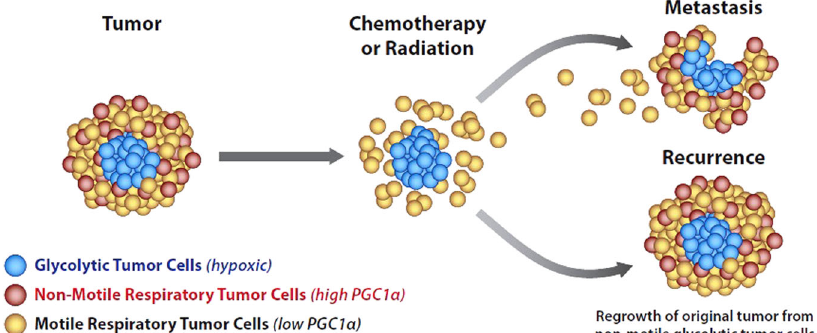
Fig. 3 The source and location of reactive oxygen plays a dualistic role in tumor cells. NADPH oxidases are tethered to the cellular membrane in part by Akt. These complexes generate superoxide that oxidizes redox-sensitive sulfhydryl groups in the cytoplasm. This leads to inactivation of cellular phosphatases, activation of cellular kinases, and polymerization of F-actin, allowing motility. In contrast, mitochondrial- derived reactive oxygen may be a highly pro-apoptotic mechanism, leading to VDAC channel formation, loss of mitochondrial potential and, thus, loss of ATP. Fusion mitochondria may be highly susceptible to these events, while fi ssion mitochondria may be less susceptible to these events, and fi ssion may serve as a defense mechanism against mitochondrial reactive oxygen. Acknowledgement and credit to Brian